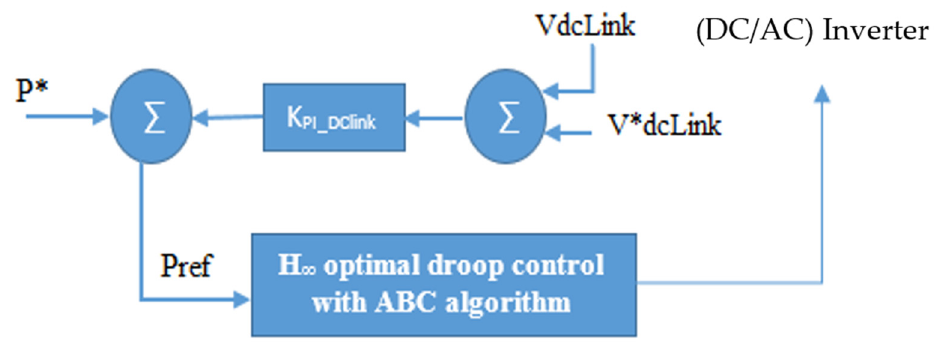
Figure 13. DC link voltage controller.